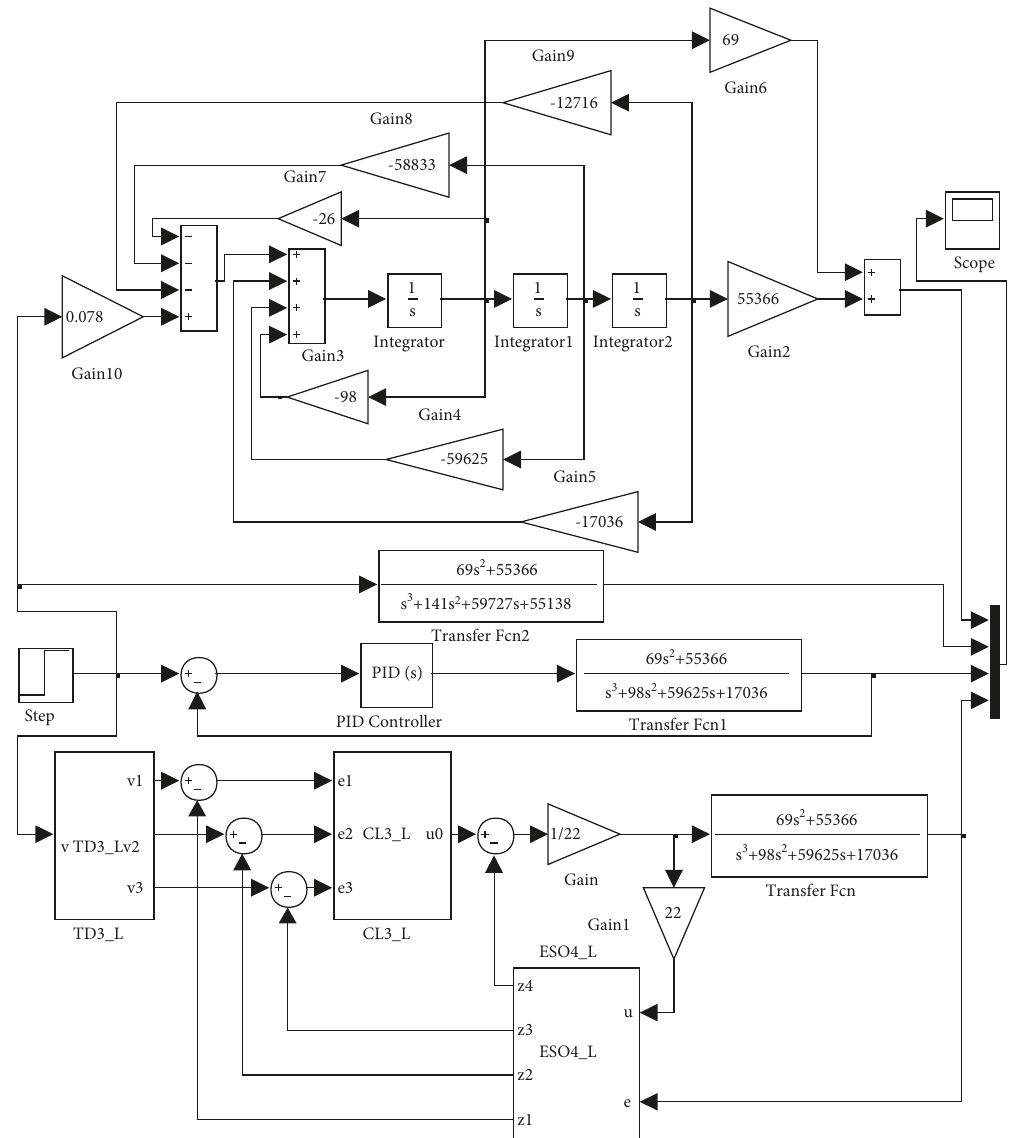
Figure 36: Simulation model of control system based on four control strategies.